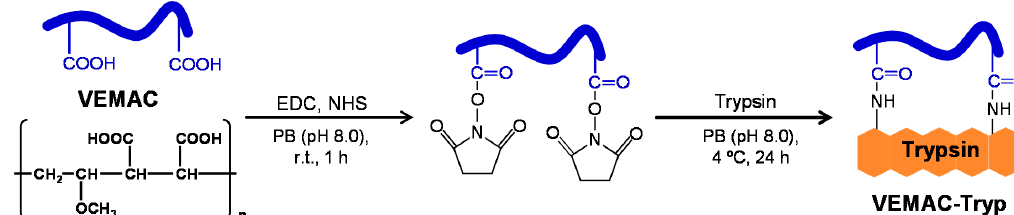
Scheme 1. Reaction scheme for synthesizing vinylmethylether-maleic acid copolymer-modified trypsin (VEMAC-Tryp) via multi-point conjugation. EDC: 1-ethyl-3-(3-dimethylaminopropyl) carbodiimide